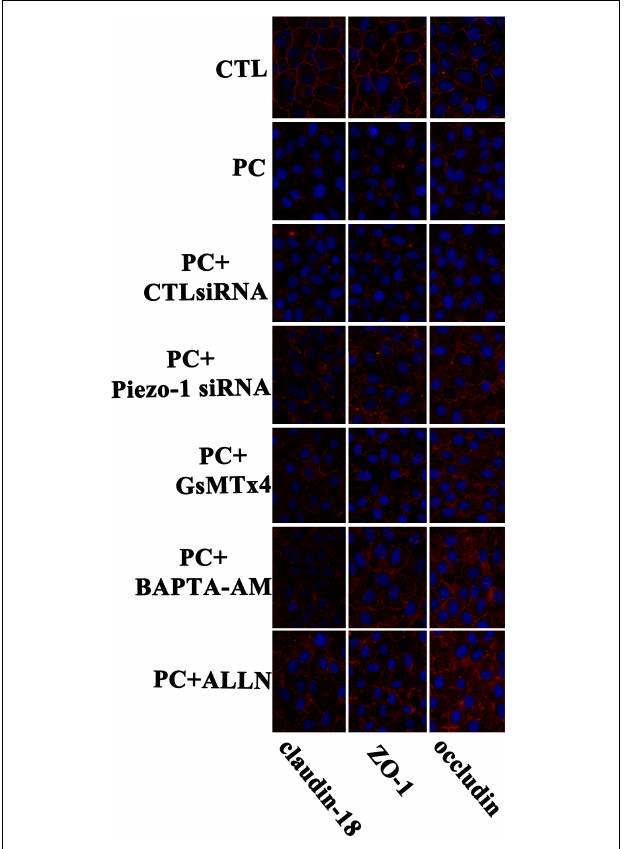
FIGURE 7 | Immunofluorescent staining for of TJ proteins (occludin, ZO-1 and claudin-18) in HSAECs. Cells propagated under normal atmospheric pressure were set as the control (CTL). Cells exposed to 10 cmH 2 O of pressure for 12 h were marked as the ‘pressure culture’ (PC) group. TJ proteins were visualized by Alexa Fluor R (cid:13) 594-linked secondary antibody (red fluorescence). Nuclei were labelled with DAPI (blue fluorescence). The results shown are representative photos of the outcomes obtained in 6 independent